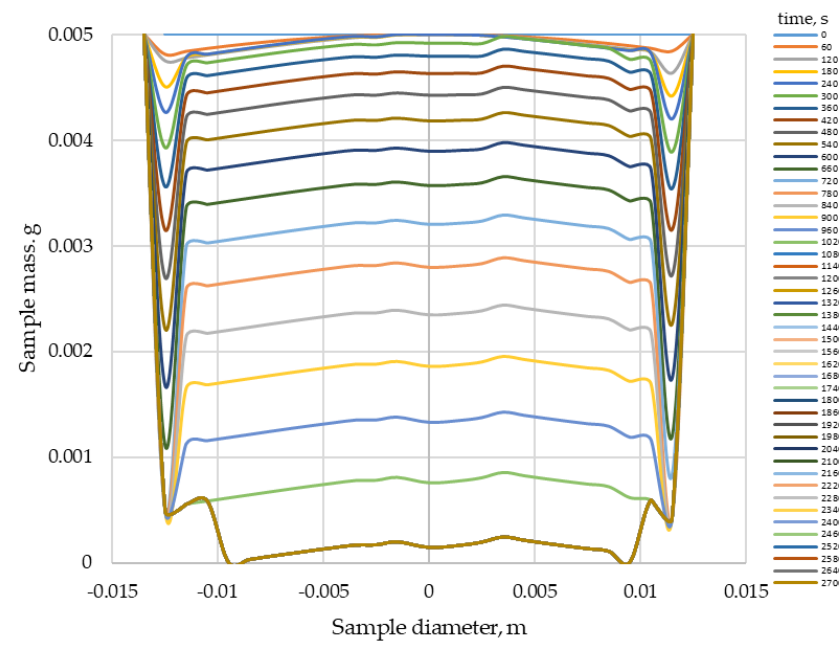
Figure 17. Calculations results of the time distribution along the sample diameter.